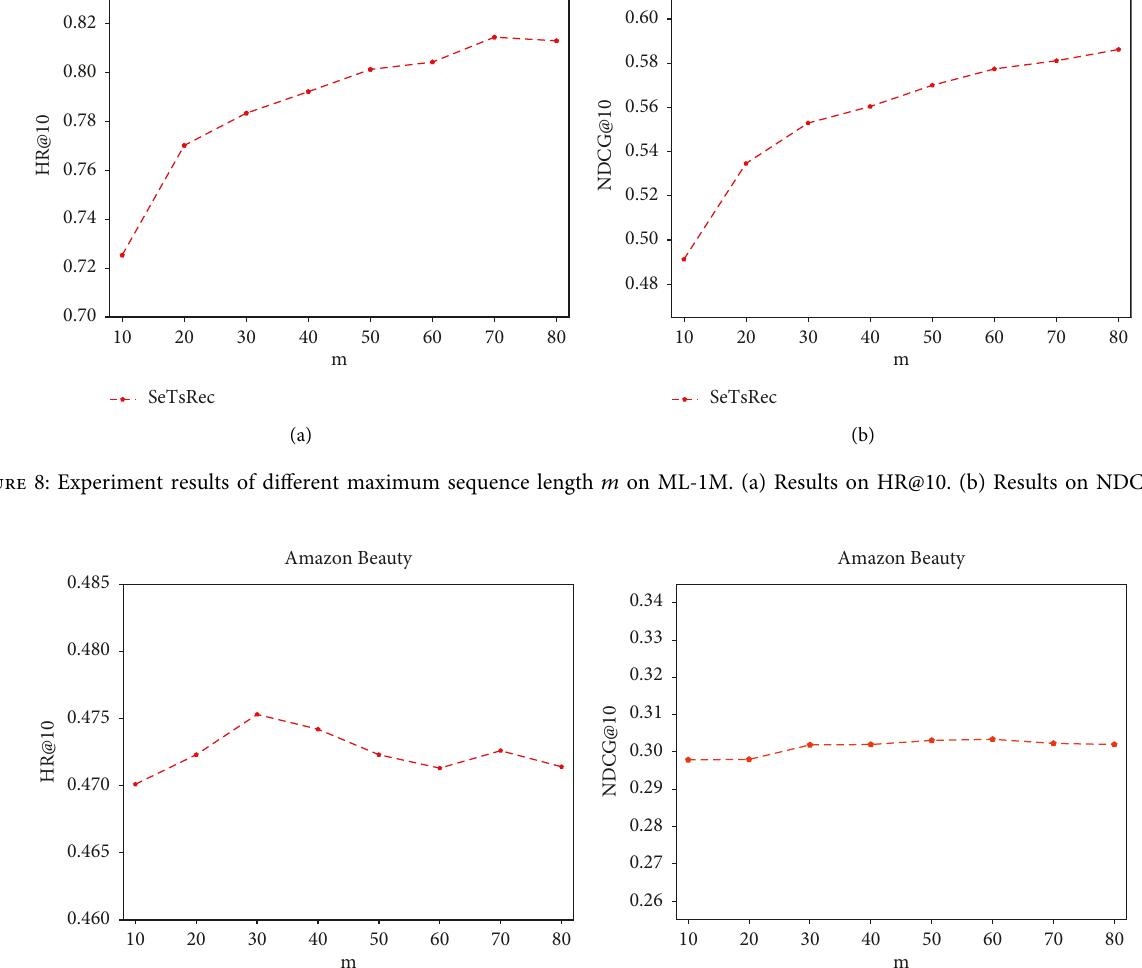
Figure 9: Experiment results of different maximum sequence length m on AM-BE. (a) Results on HR@10. (b) Results on